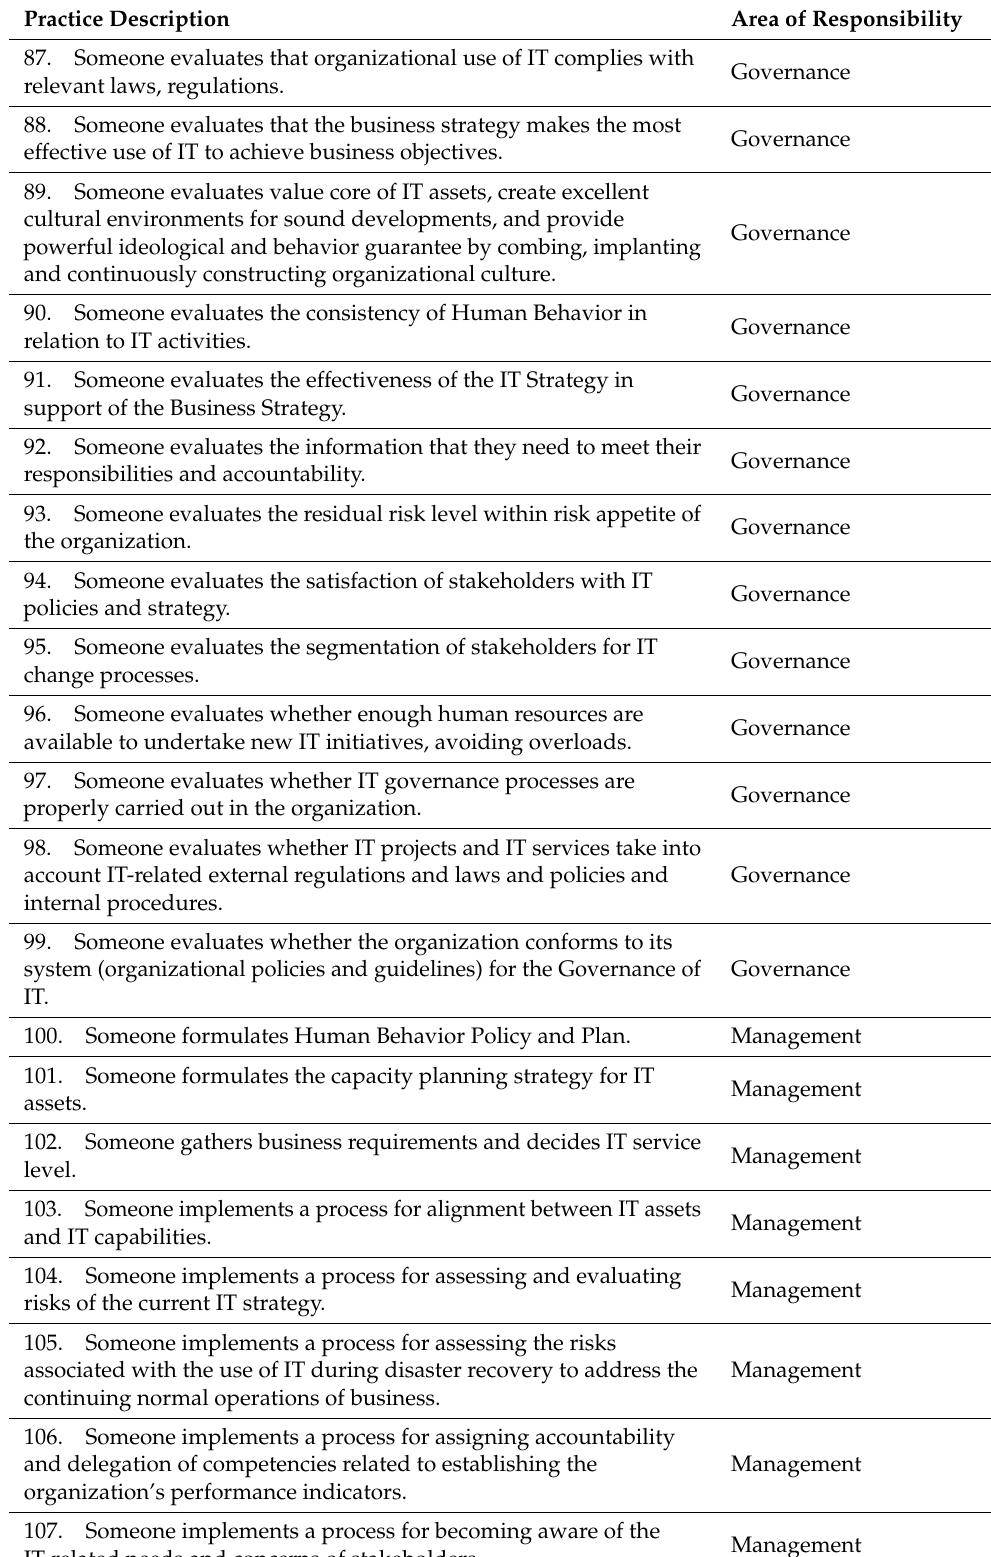
Table A1. Cont. Practice